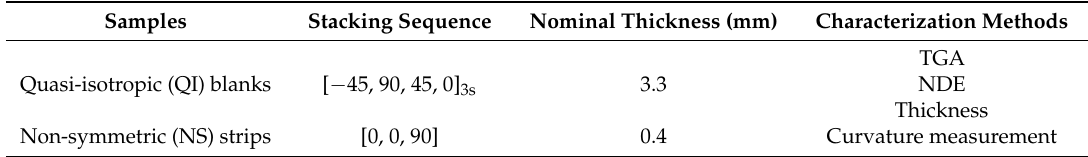
Table 1. Composite samples analyzed in this work and the characterization